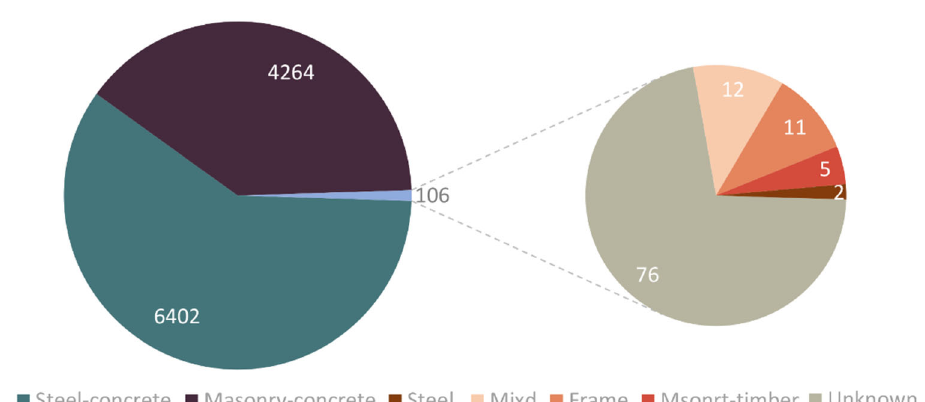
Figure 5. Number of different building structures.